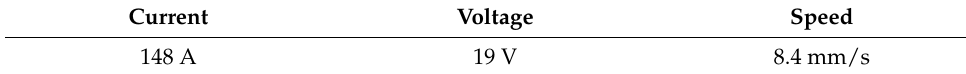
Figure 9. Contour Plot of Distortion vs. Speed, Voltage. Table 2. Optimum weld parameters.